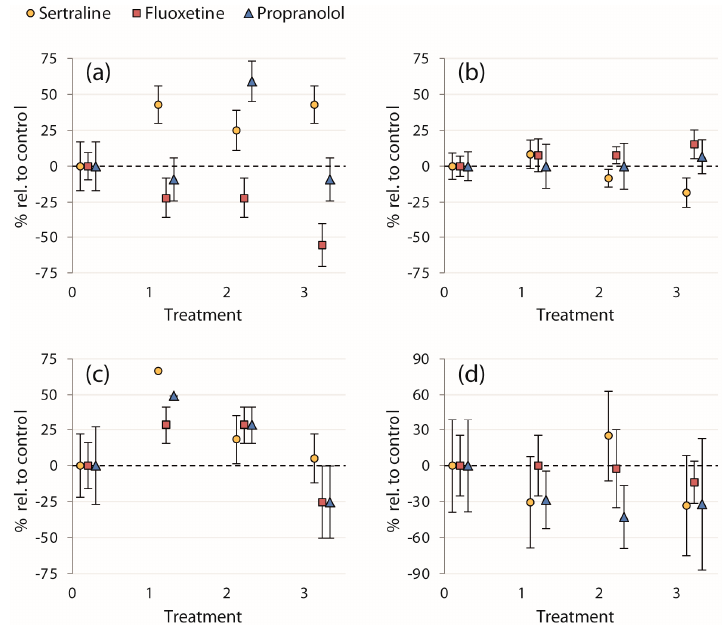
Figure 2. Calculated mean percent changes in endpoints relative to the control treatments ((treatment mean − control mean)/control mean × 100) ± SEM (% of each treatment mean): ( a ) proportion of fish entering the strike zone; ( b ) initial escape velocity after the strike; ( c ) proportion of fish entering cover after the strike; and ( d ) time taken to reach cover. Treatments on the x -axis are 0 : control; 1 : 0.12 and 0.1 μ g/L; 2 : 89 and 1 μ g/L; and 3 : 300 and 100 μ g/L for sertraline and fluoxetine/propranolol, respectively.